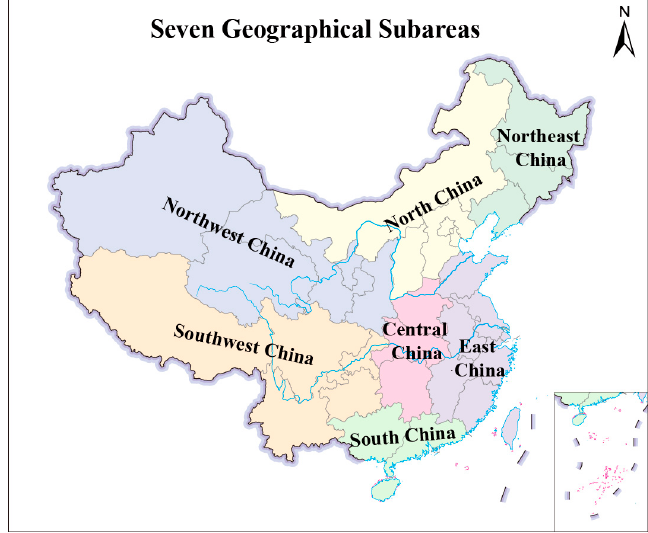
Figure 3. Seven regions of China.